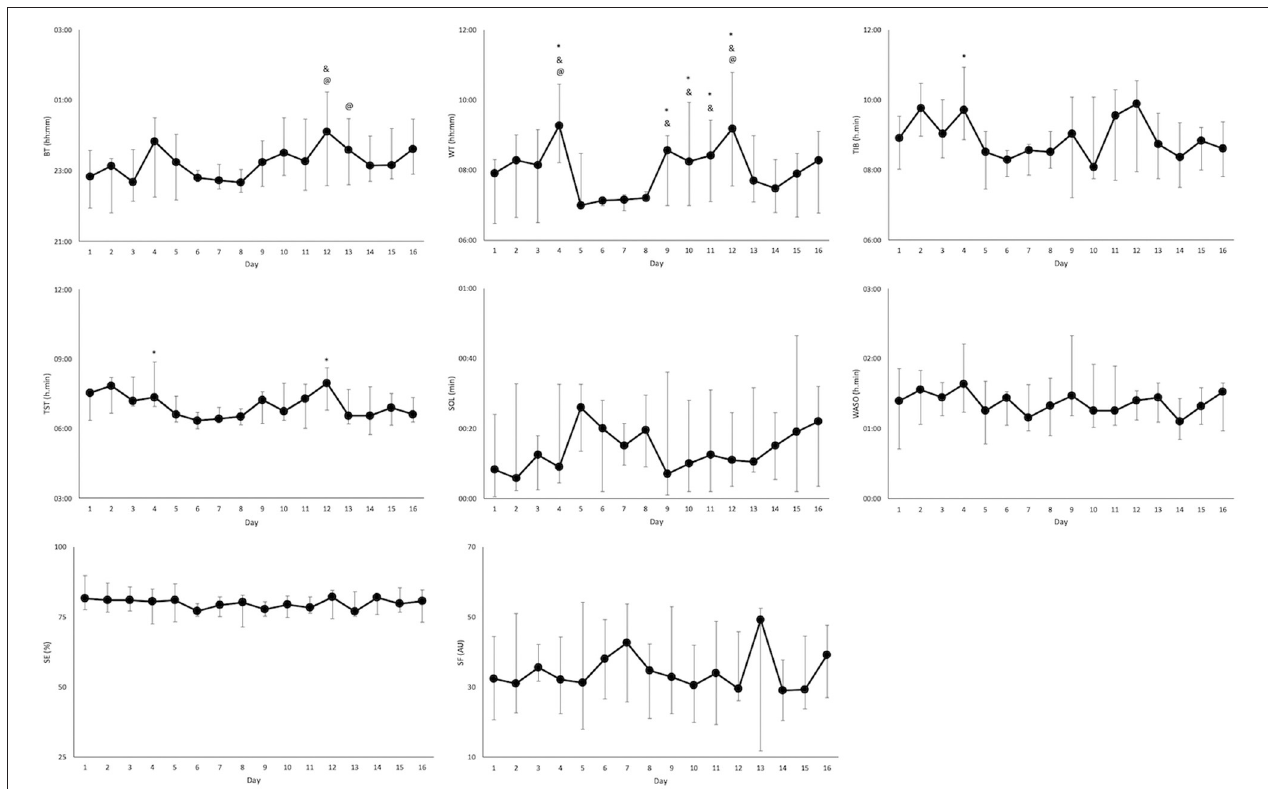
FIGURE 3 | Sleep parameters (median and interquartile range) over the 16-day period for the athletes that attended training camp ( n = 11). Significant differences from night 1 of camp (night 6), night 2 of camp (night 7), and night 3 of camp (night 8) are indicated by *, &, and @, respectively. BT, bed time; WT, wake time; TIB,